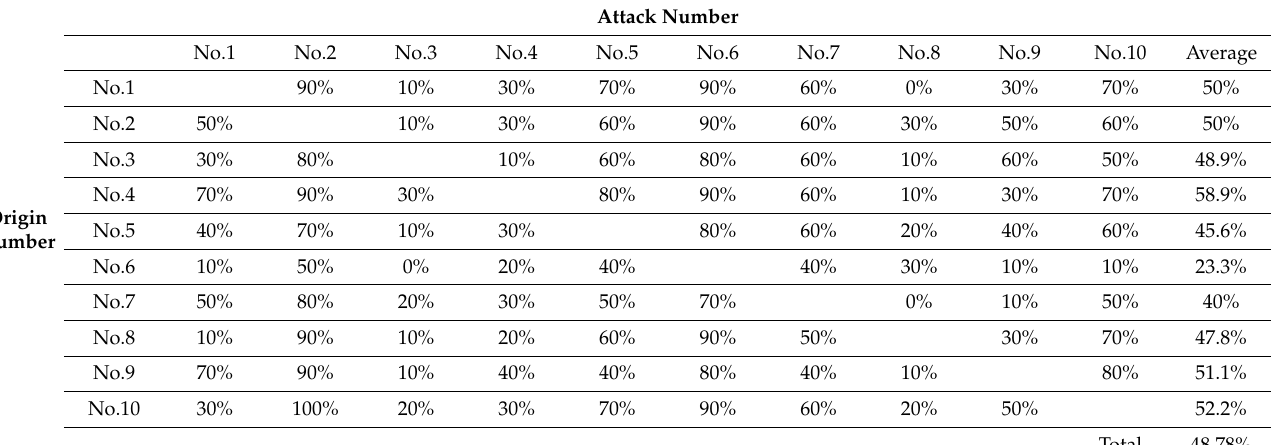
Table 8. Digital impersonation attacks against 22-person face recognition system. Attack